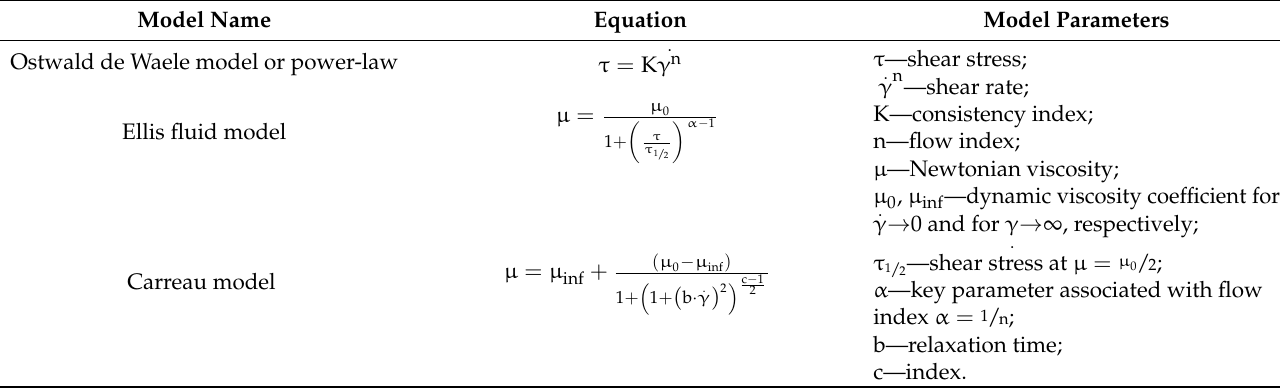
Table 8. The main technical characteristics of the rotary rheometer «Kinexus ultra+».